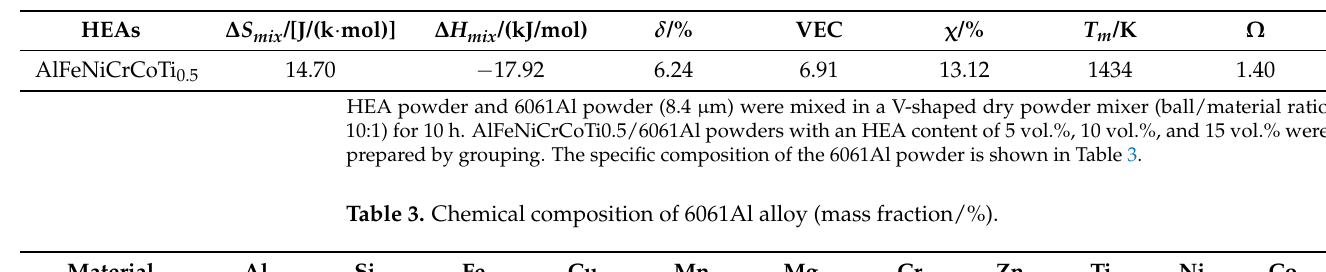
Table 2. High-entropy alloy system parameters.